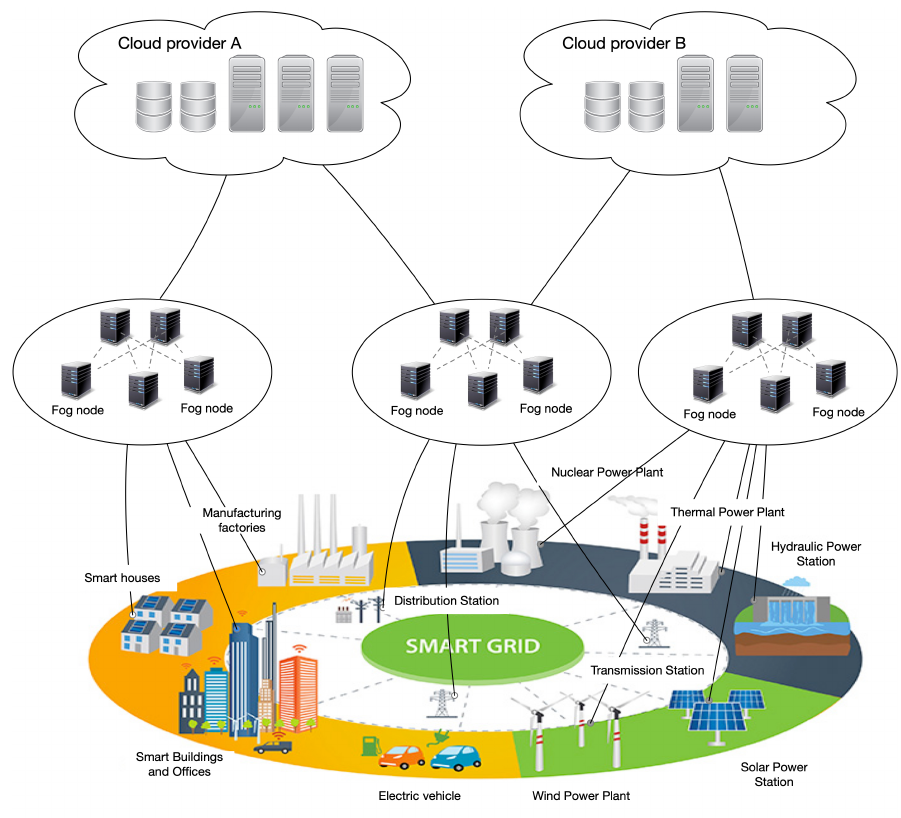
Figure 6. A fog–cloud-based architecture for smart